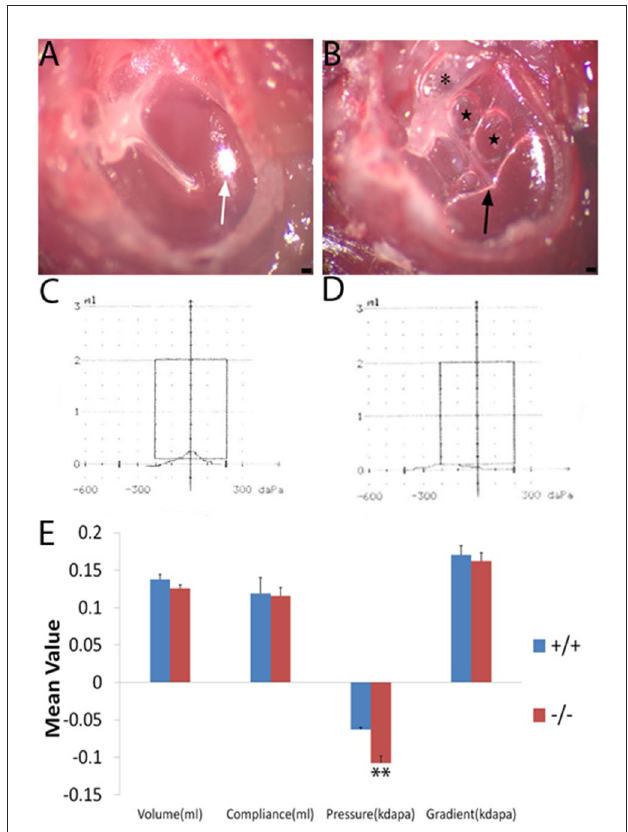
FIGURE2 Tympanic membrane image and a comparison of the mean value of tympanometry parameters. Nine wild-type mice ( + / + ) and eight mutant mice (-/-) were used to measure the tympanometry at the age of 2 months. (A, B) : Tympanic membrane image ( n = 3, each group) under an anatomical microscope. The wild-type mouse (A) displays a normal tympanic membrane with a subuliform light cone (white arrow) on its anteroinferior quadrant. In the ear of the mutant mouse (B) , the retraction and adherence of the tympanal flaccid part (asterisk) were visible, hyperemia around the malleus, effusion (black arrow), and bubbles (star) in the middle ear cavity and an abnormal light cone were detected. (C, D) : The wild-type (C) mouse shows a normal A-type curve with a peak at 0 pressure. The mutant mouse (D) exhibits an abnormal C-type curve with a peak at negative pressure. (E) Significant differences in pressure were noticed between the wild type and mutant mice at the age of 2 months. Error bar represents the standard error (SE) of the mean. * P < 0.05, ** P < 0.01. Scale bar = 50 µ